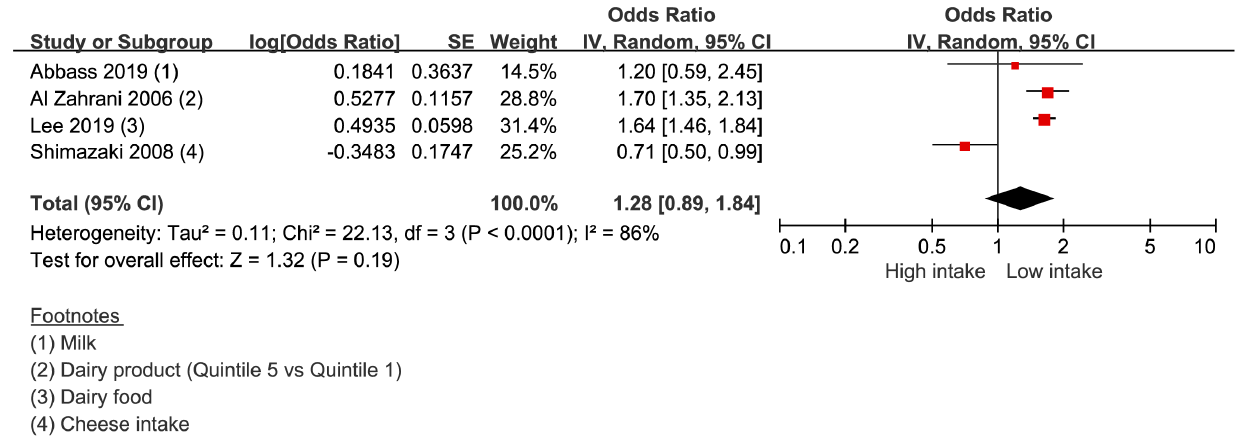
Figure 3. Risk of periodontal disease with dairy products [26–29]. -red color: weight for overall effect; -black color: 95% confidence interval.